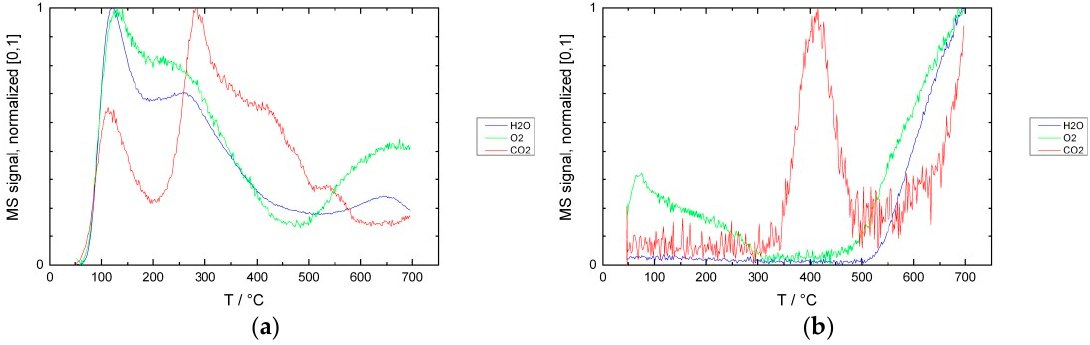
Figure 1. TPD in He after exposure to ambient air ( a ), subsequent measurement ( b ).